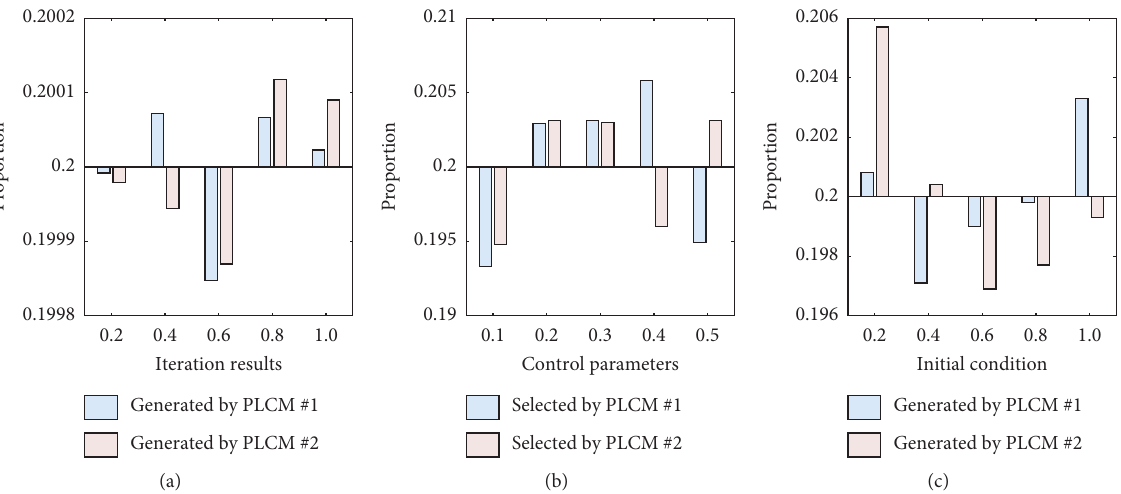
Figure 5: Uniformity evaluation. (a) Uniformity of iteration results. (b) Uniformity of control parameters. (c) Uniformity of initial conditions.